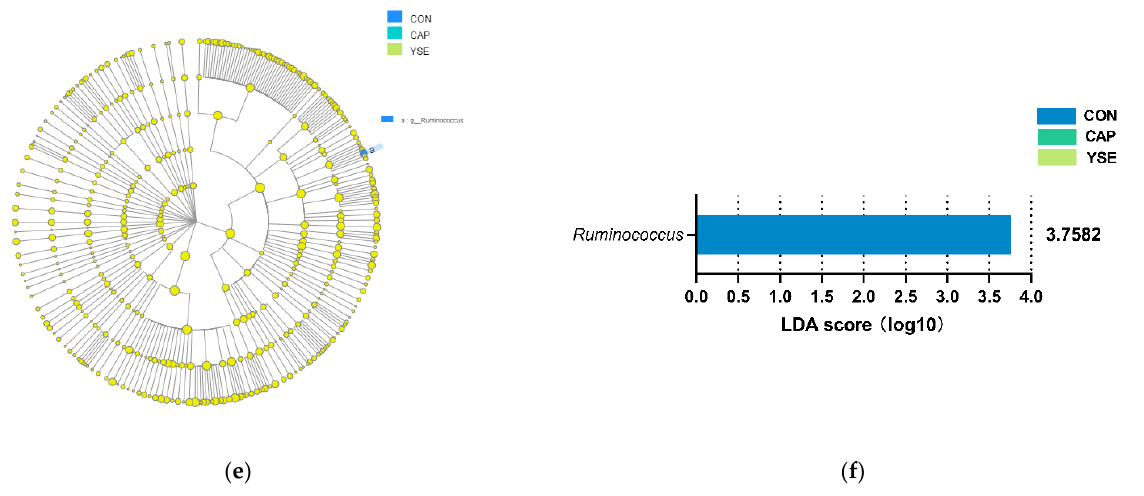
Figure 2. Relative abundance of rumen bacteria at ( a ) phylum and ( c ) genus levels in the 3 groups. Histogram of group difference test for rumen bacteria at ( b ) phylum and ( d ) genus levels. ( e ) LEfSe multilevel species hierarchy tree diagram; LDA > 3.5. ( f ) LDA discriminant result graph LDA > 3.5. CON: control group; CAP: capsaicin group; YSE: Yucca schidigera extract group. * 0.01 < p ≤ 0.05; ** 0.001 < p ≤ 0.01; *** p ≤ 0.001.